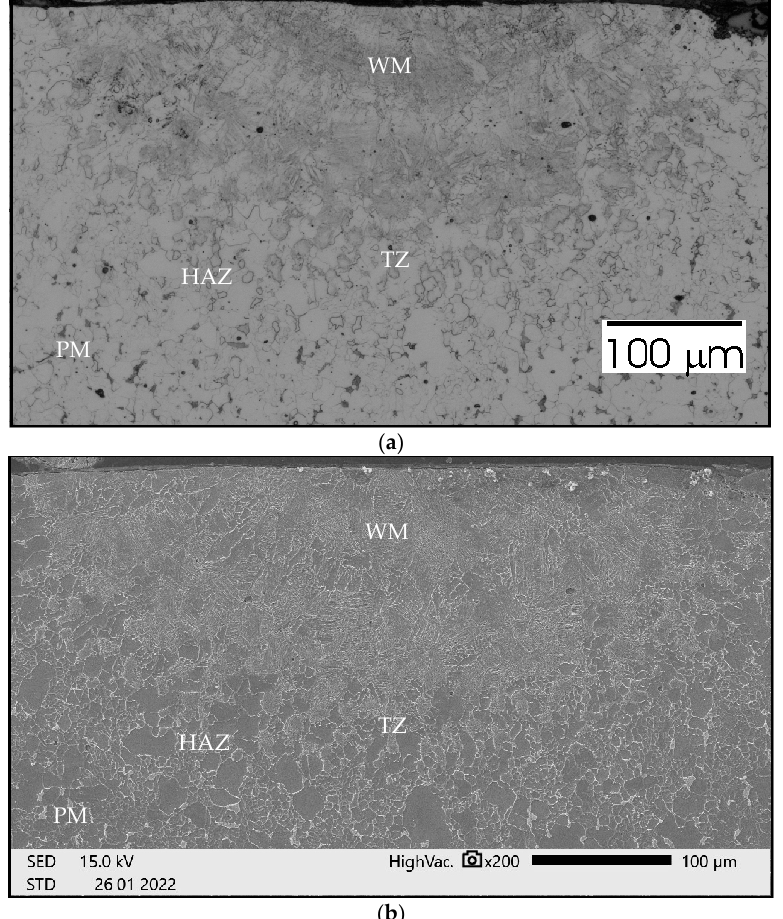
Figure 23. Sample no 3 reached with resonance frequency 1385 Hz acoustic vibration delivered parallelly: ( a ) Metallography ( b ) SEM; PM—parent metal, HAZ—heat affected zone, TZ—transition zone, WM—weld